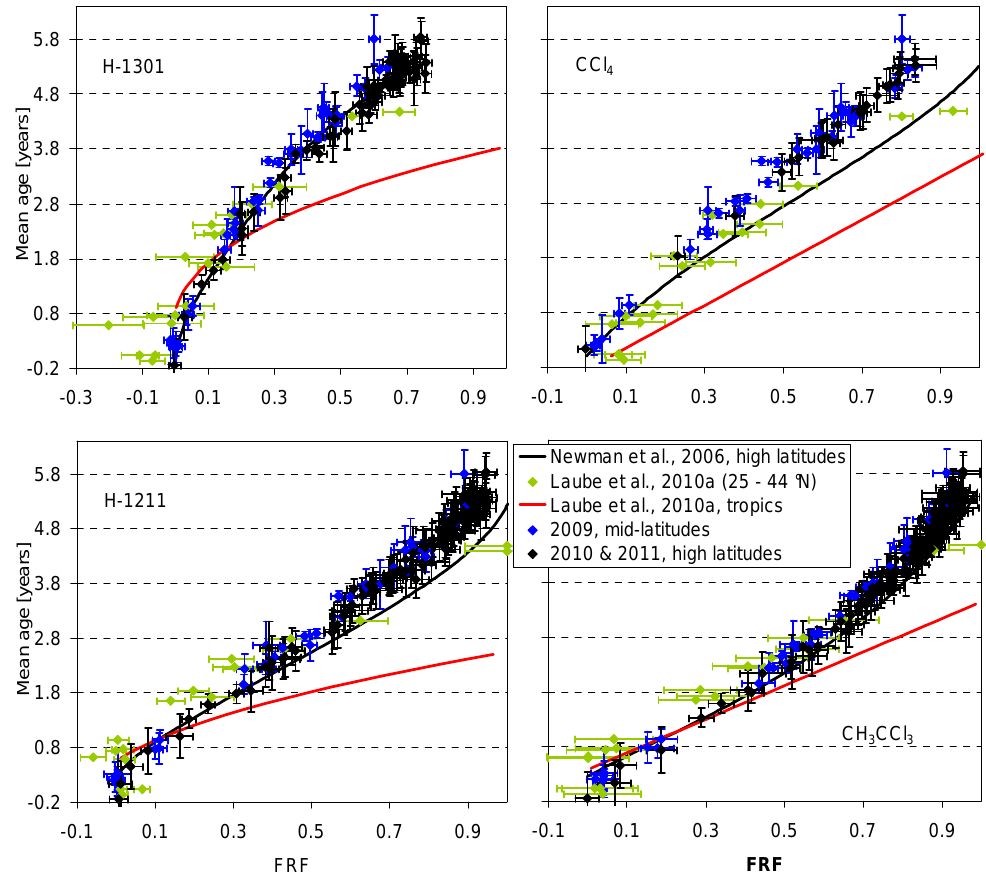
Fig. 5. Same as in Fig. 3 but for H-1301, H-1211, CCl 4 and CH 3 CCl 3 . Figure 5. Same as in Figure 3 but for H-1301, H-1211, CCl tropospheric growth) are coupled by stratospheric